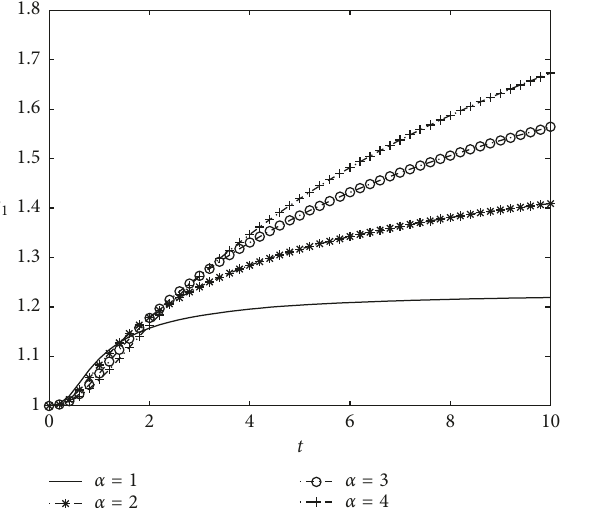
Figure 11: η over time for various values of α when applying the 1 third nonlinear adaptive controller.